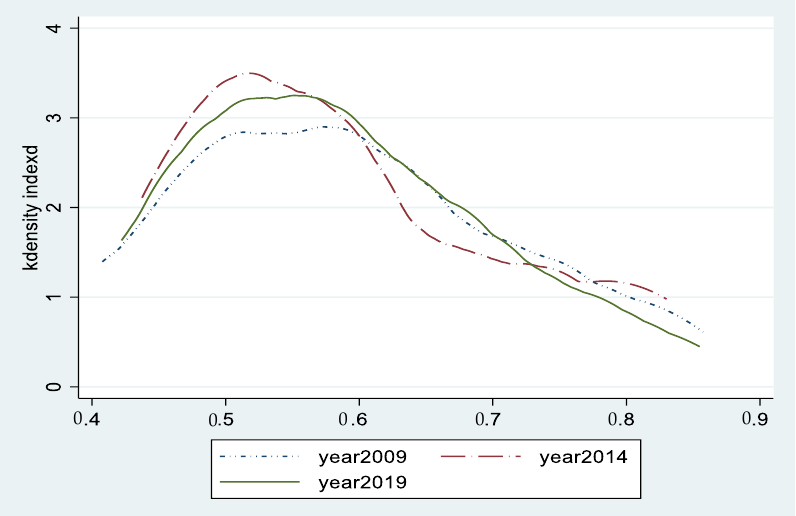
Figure 7. The distribution dynamics of the coordinating development index of the aging industry and the regional economy